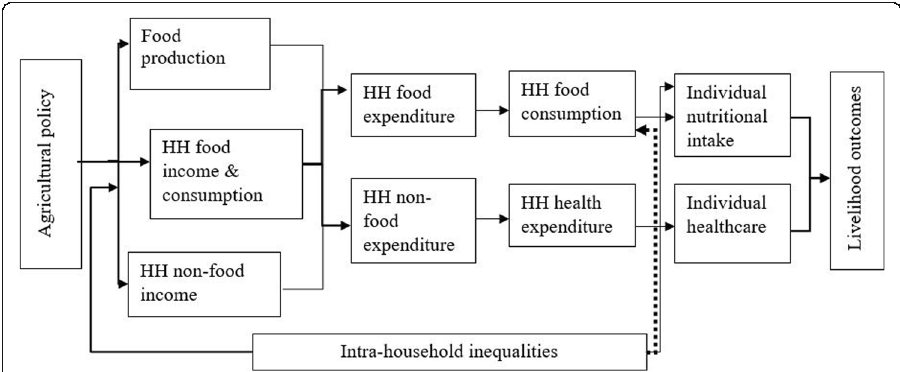
Fig. 1 Linkages between agriculture and nutrition: effects of intra-household inequality. Source: Adapted from Headey et al.